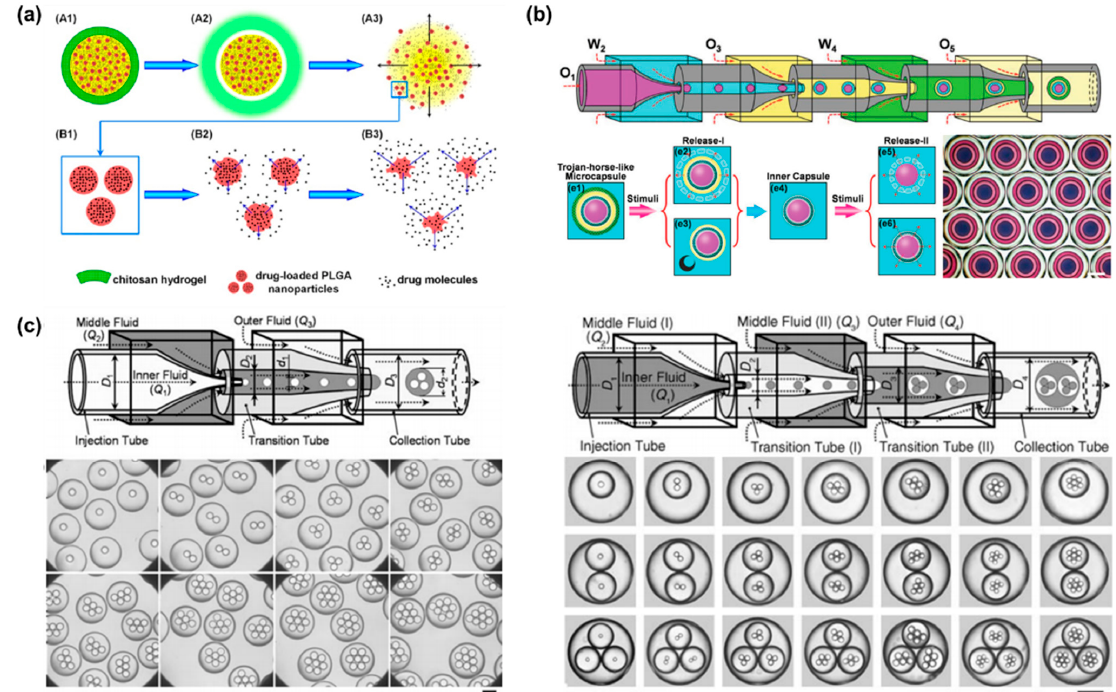
Figure 4. ( a ) Schematic illustration of programmed sequential drug release from multi-stimulus- responsive microcapsules. Acid triggered the decomposition of chitosan resulting in release of free drug and drug-loaded PLGA nanoparticles. Then PLGA degradation achieved sustained release.